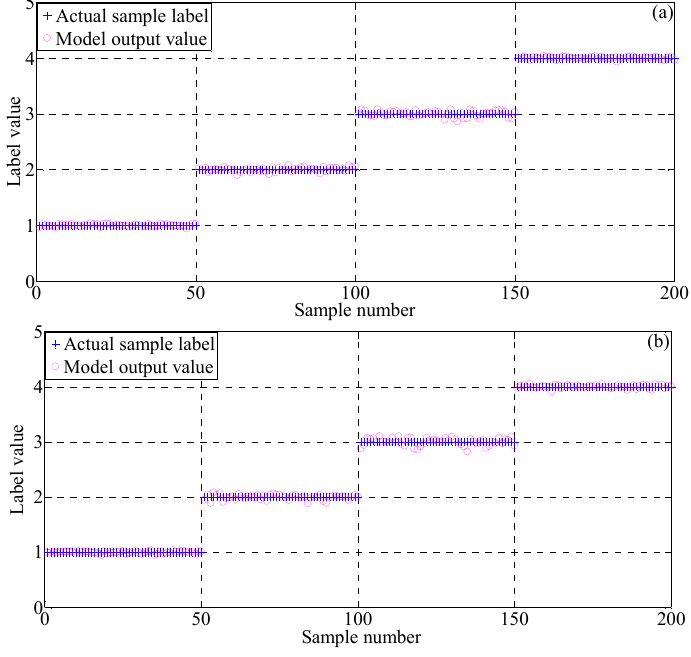
Figure 8. ( a ) Training results and ( b ) testing results for dataset II by SDAE.